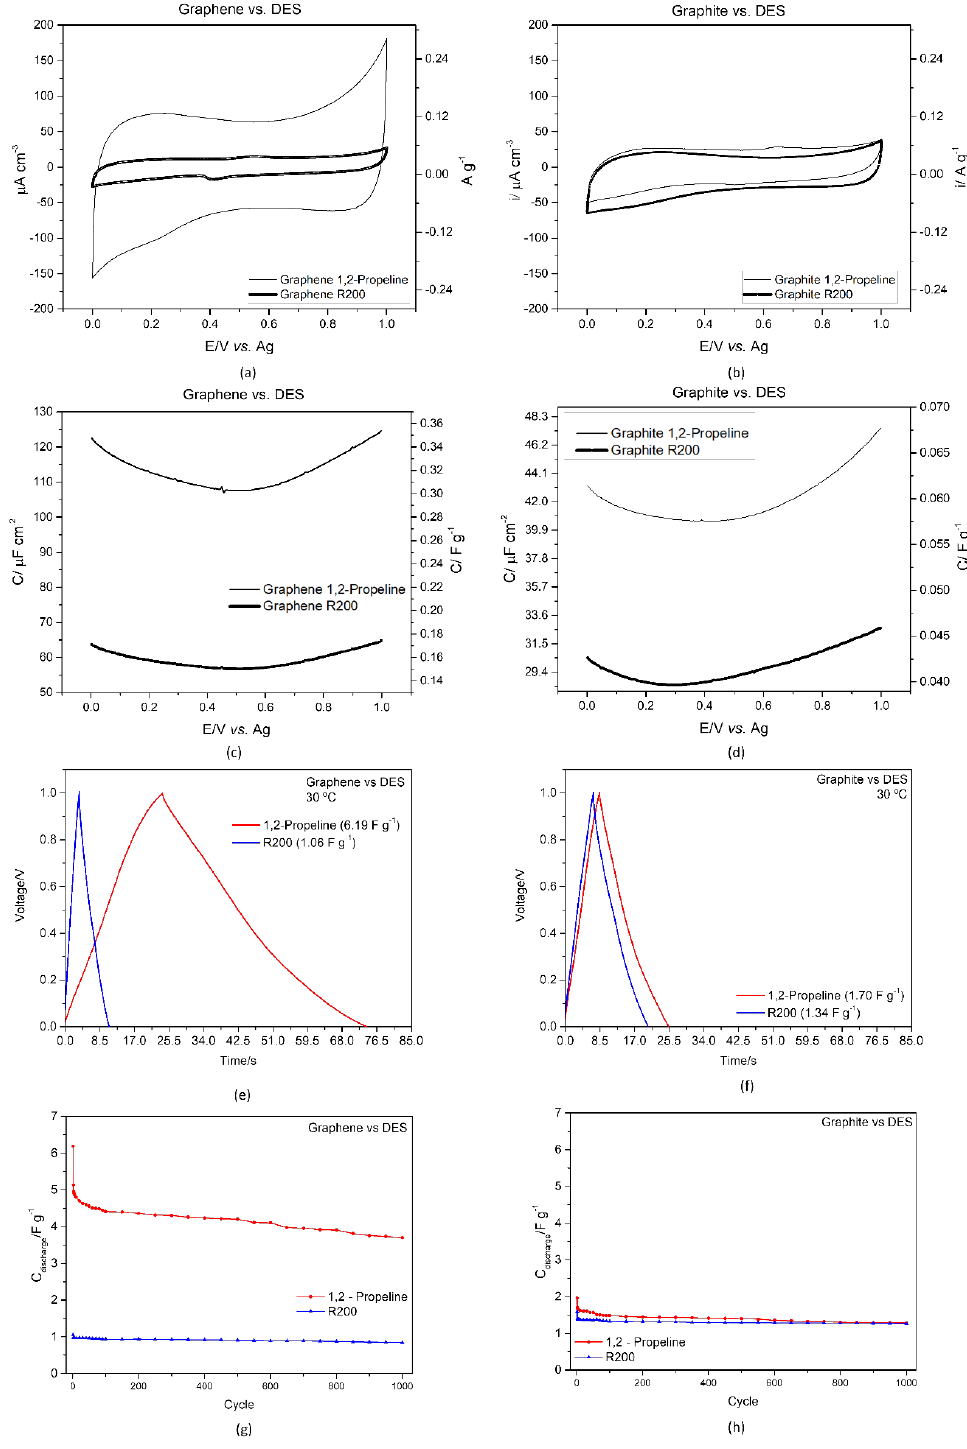
Figure 4. Electrochemical testing of graphene and graphite at 30 °C ( a , b ) — cyclic voltammetry; ( c , d ) — capacitance-potential curve; ( e , f ) — charge/discharge at 1 A g – 1 ; ( g , h ) — gravimetric capacitance for 1000 cycles.